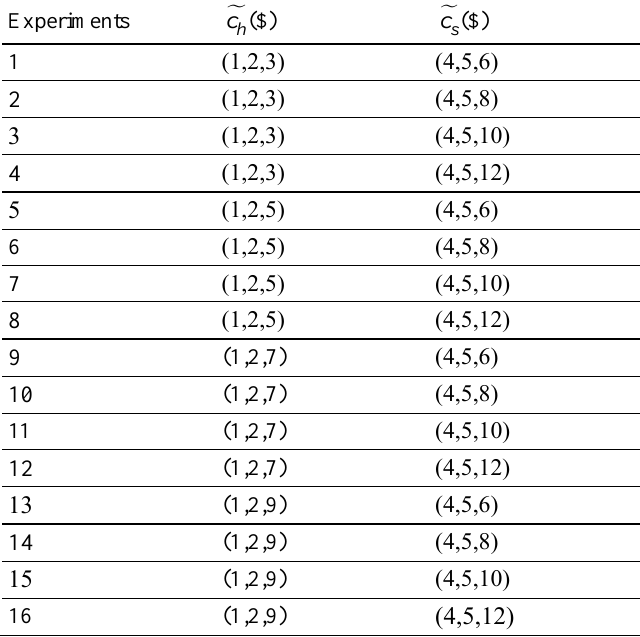
Table 6. Performed experiments and values of the cost parameters Experiments